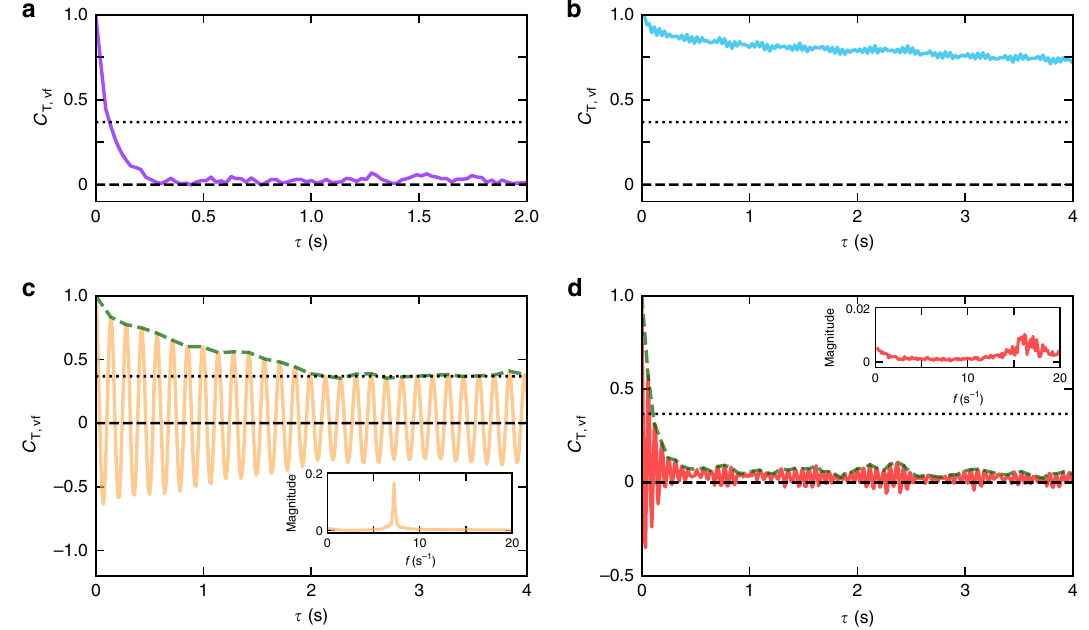
Fig. 5 Temporal correlations of the velocity fi elds for different dynamic phases. a Gas. E = 1.60 V μ m − 1 . ϕ = 0.054. b Vortices. E = 1.92 V μ m − 1 . ϕ = 0.108. c Rotating fl ocks. E = 2.60 V μ m − 1 . ϕ = 0.144. d Spinners. E = 2.80 V μ m − 1 . ϕ = 0.054. Inserts demonstrate FFTs of corresponding C in rotating fl ocks and spinners phases. Dotted lines indicate 1/ e value. Green dashed lines in ( c , d ) show the positive envelopes of the correlation